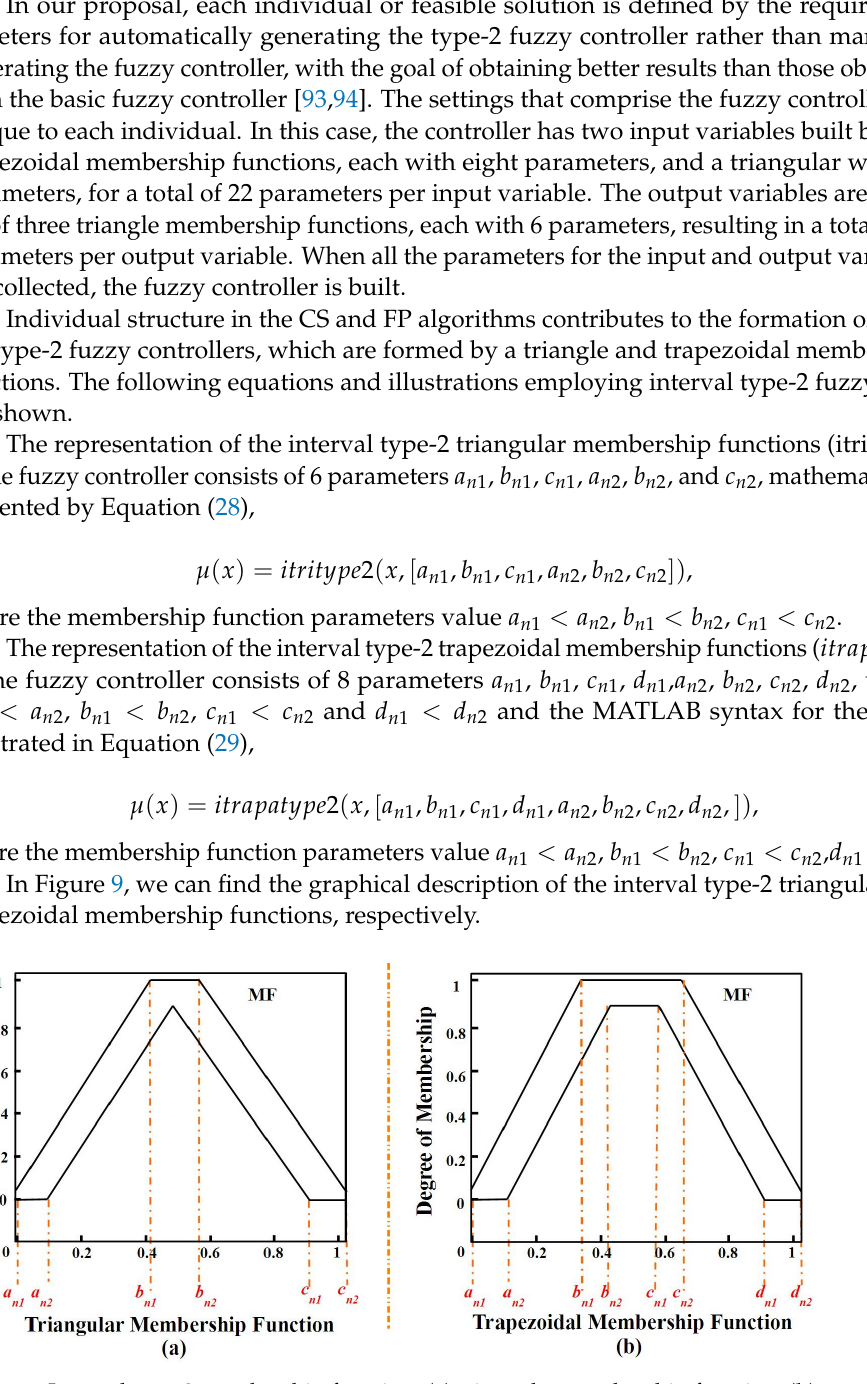
Figure 9. Interval type-2 membership function. ( a ) triangular membership function; ( b ) trapezoidal membership